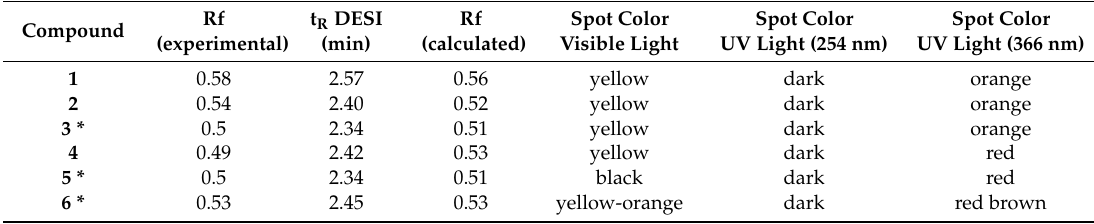
Table 2. Rf value and calculation from crude extract of C . (D.) austronanciensis (Figure 1, band 2). Compound